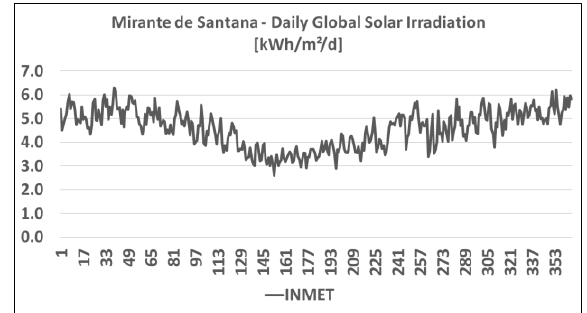
Figure 5. Average daily solar irradiation values from